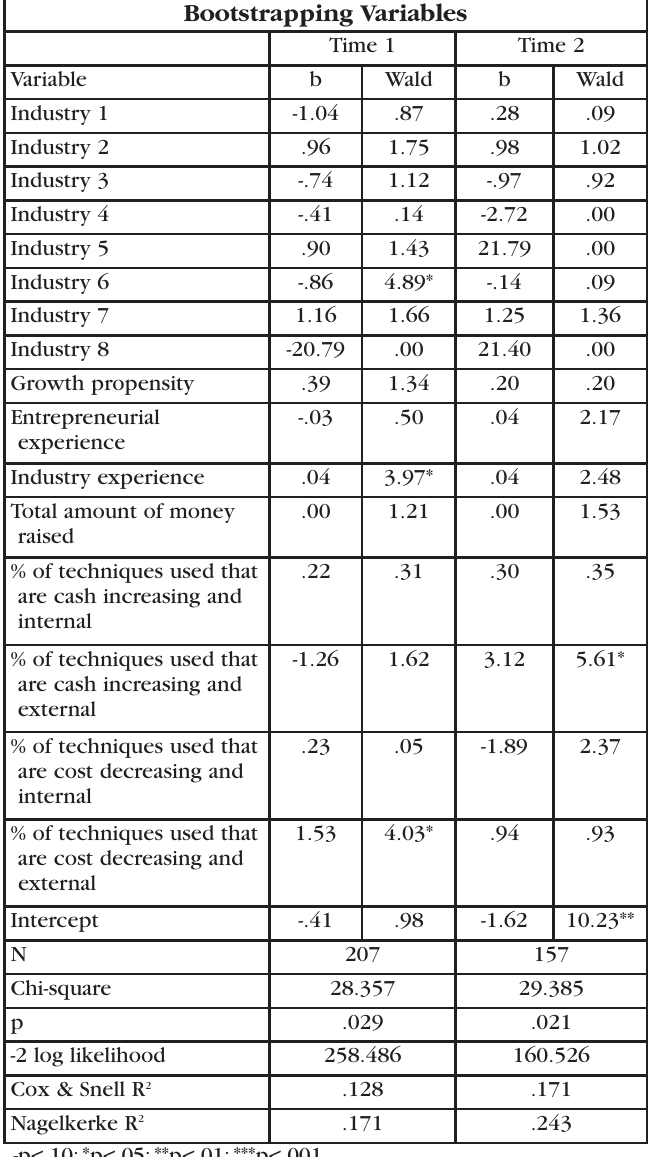
Table 3. Positive Cash Flow Regressed on Bootstrapping